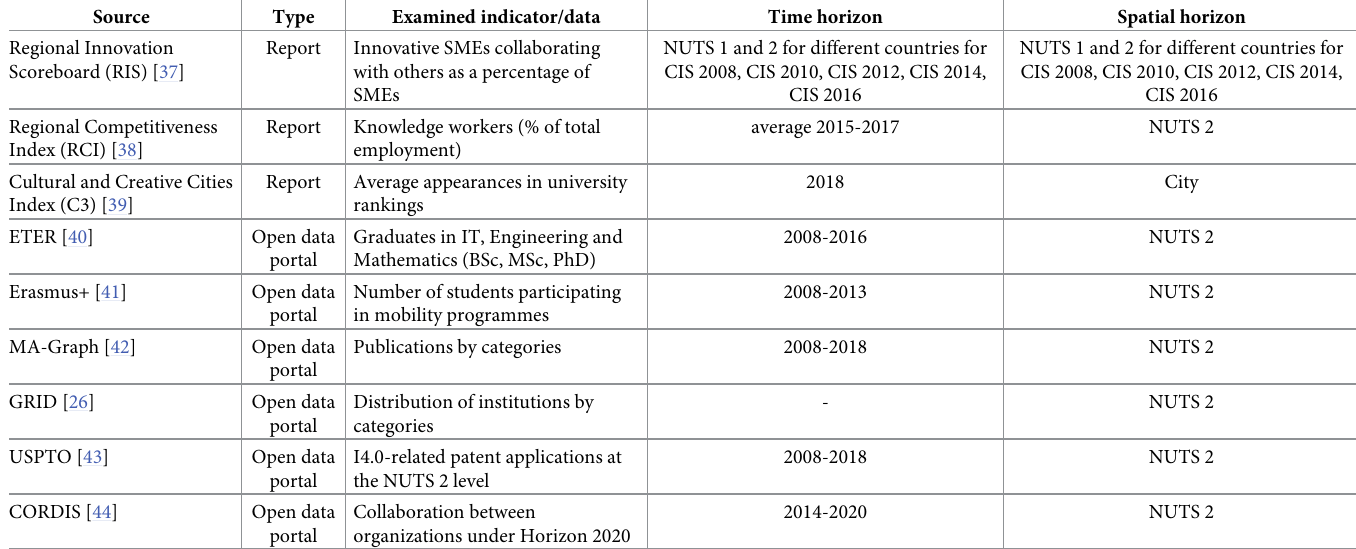
Table 1. Analysed reports and open data portals as data